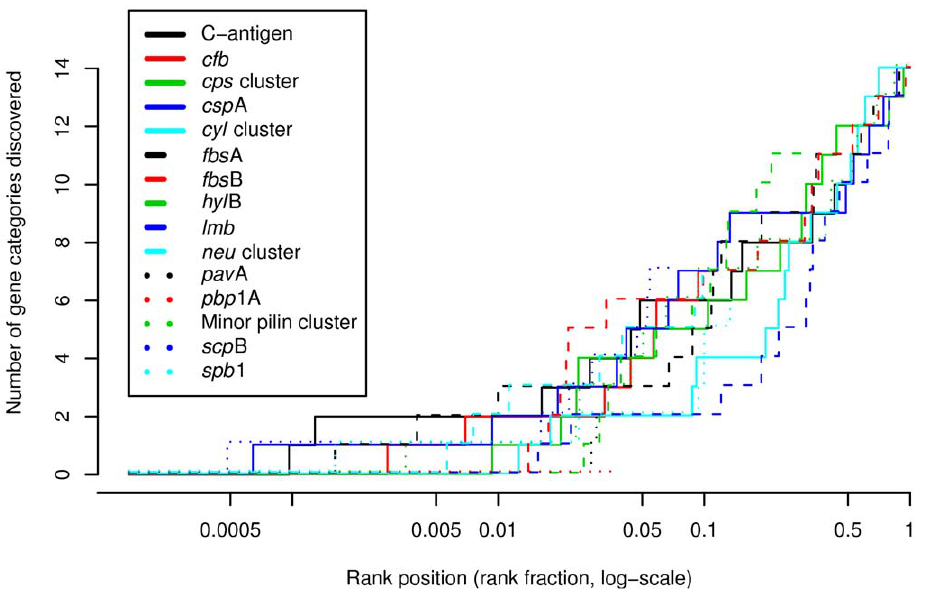
Figure 3. Number of other gene categories discoverable at a certain rank position. This analysis evaluated how many virulence gene categories are discoverable at a given position of a prioritized rank. A category is considered discoverable by another if at least one virulence gene is present above a given position in the rank is being analyzed. The gene positions were measured by rank fraction (between 0 and 1) with 0 being the top of the rank and 1 at the bottom. Candidate genes were ranked by SVM/RBF algorithm (the best algorithm evaluated in Table 2).